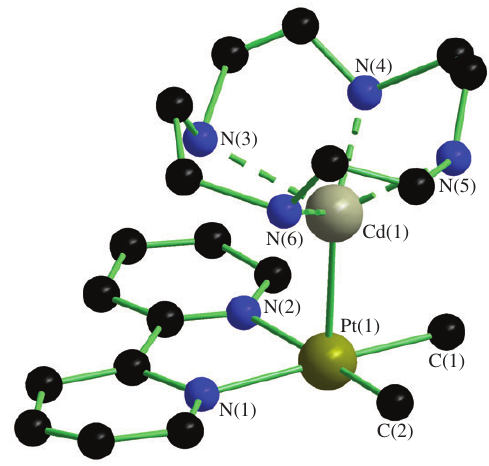
Figure 7 Structure of [Pt(bpy)(Me) et al.,